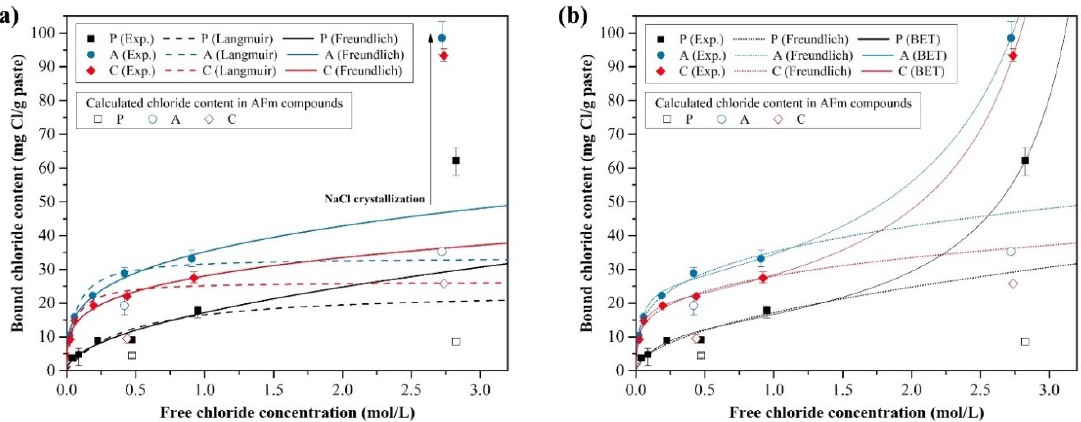
Figure 3. Chloride binding isotherms of P, A and C: ( a ) Langmuir and Freundlich isotherms; ( b ) Freundlich and Brunauer-Emmett-Teller (BET) isotherms.